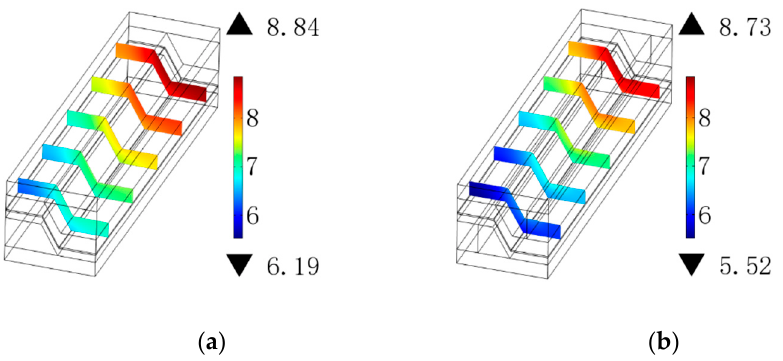
Figure 8 . Hydrogen concentration distribution: ( a ) conventional design; ( b ) vertical rib design (unit mol/m 3 ).